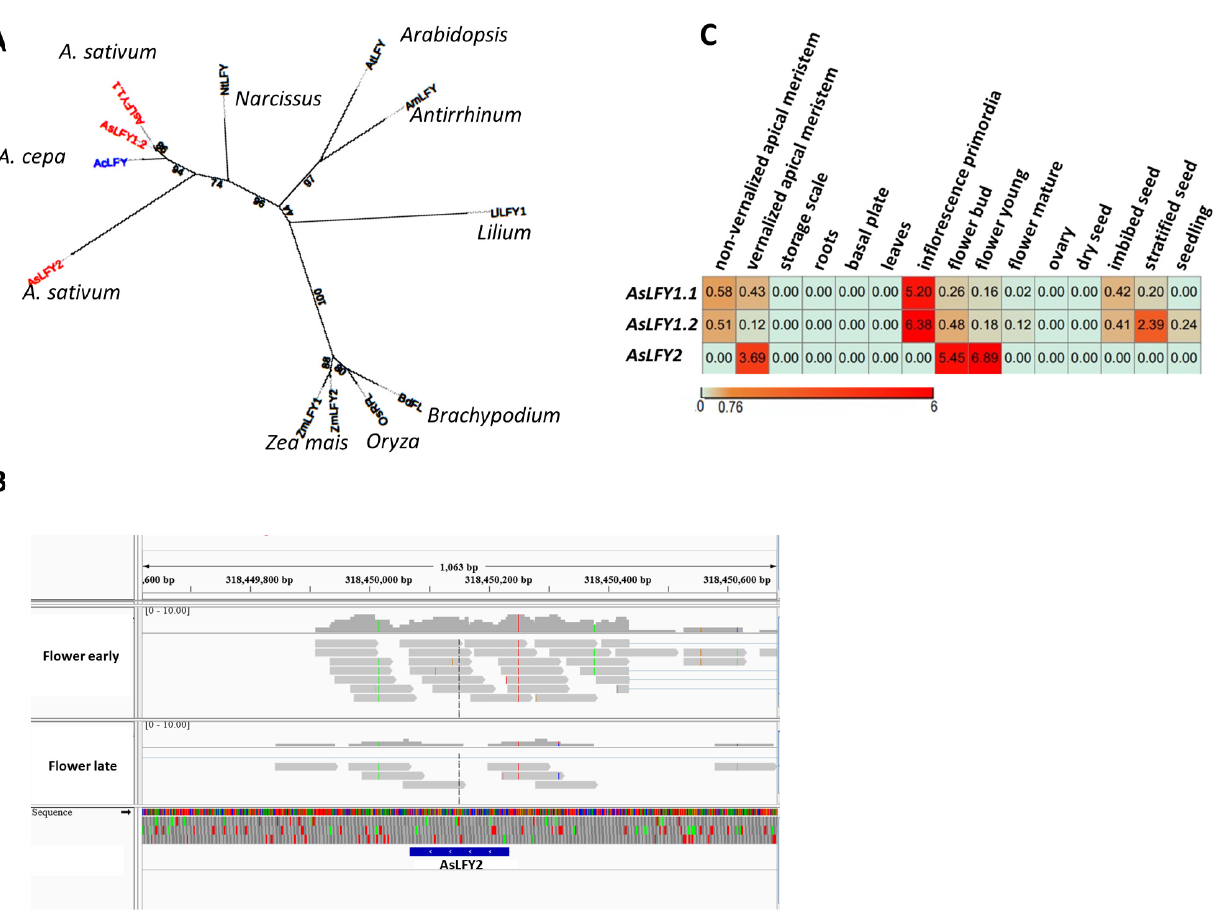
Figure 2. Genome and transcriptome analyses of garlic LFY homologs. ( A ) Interspecific phylogenetic tree of LFY-like protein sequences from onion ( Allium cepa , Ac), rice ( Oryza sativa , Os), Brachypodium distachyon (Bd), Narcissus tazetta (Nt), Lilium longiflorum (Ll), corn ( Zea mays , Zm), Arabidopsis thaliana (At), Antirrhinum majus (Am), and garlic ( Allium sativum , As). Alignment performed using the